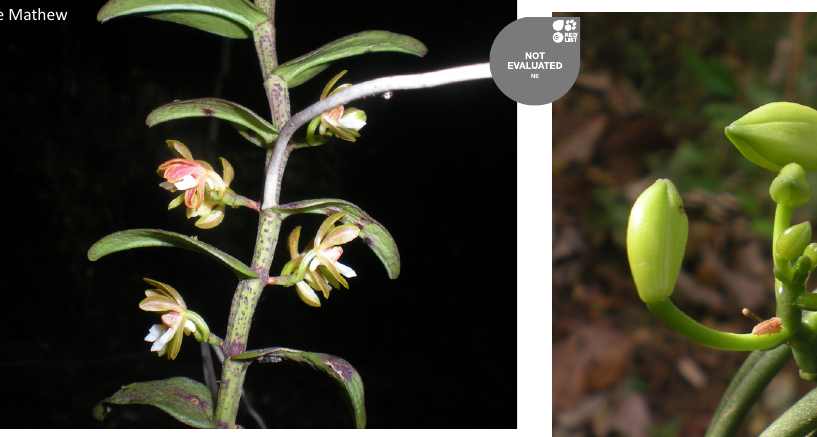
Image 7. Trichoglottis tenera (Lindl.) Rchb.f.